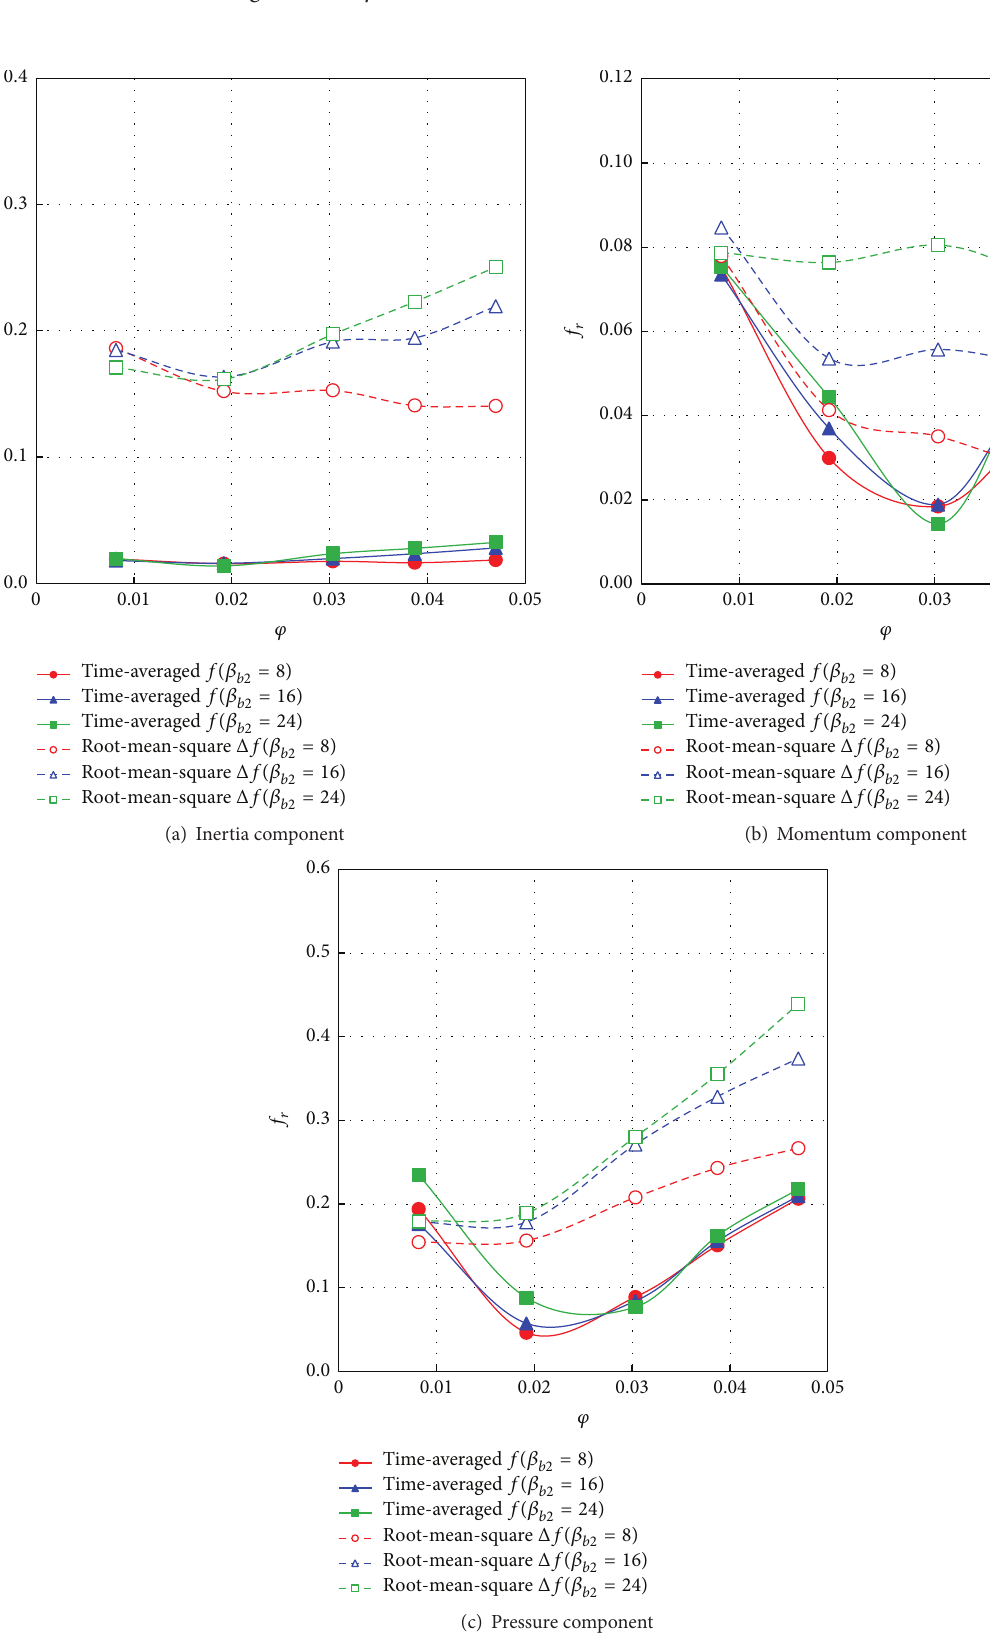
Figure 12: Each component of radial thrust coefficient ( 𝑓 𝑟 ) as functions of flow rate coefficient ( 𝜑